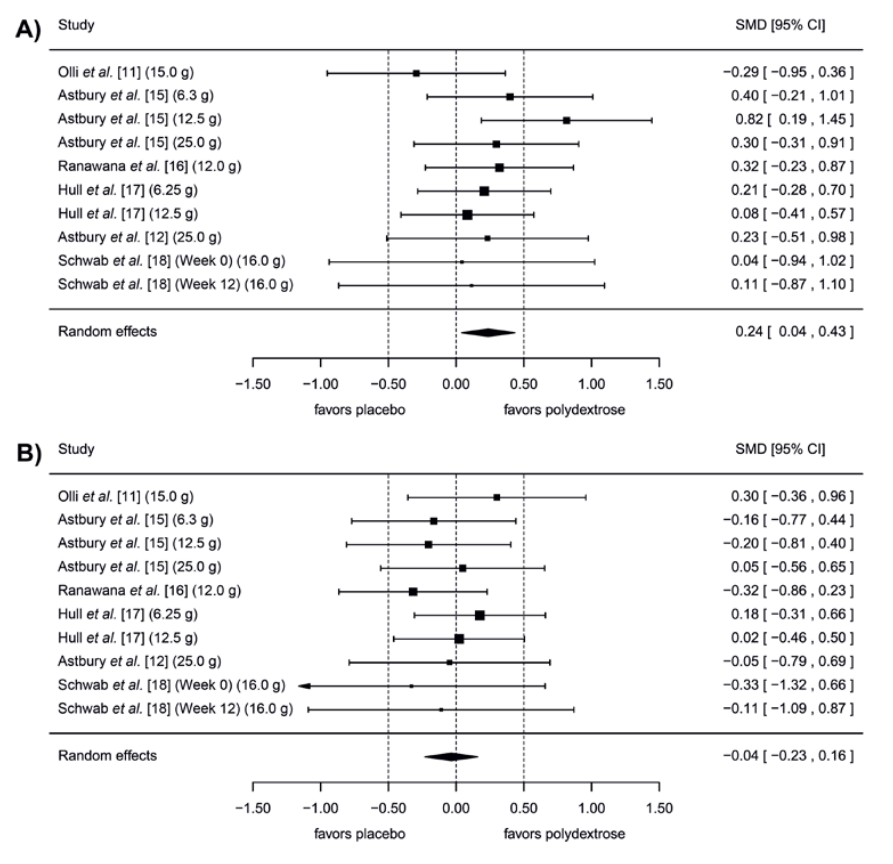
Figure 2. Meta-analysis comparing doses of polydextrose versus placebo in the studies selected for this review on the subjective feelings of Desire to Eat, adjusted to show “less desire to eat with polydextrose” if the Standardized Mean Difference calculated using Hedges’ g measure (SMD, 95% CI) favors it, ( A ) during the Satiation period and ( B ) during the Satiety period. Doses of polydextrose per day used in each treatment are presented in brackets next to each reference.